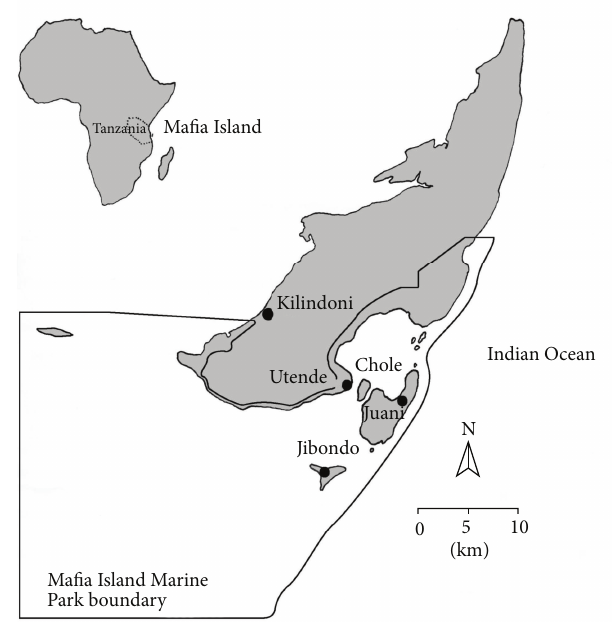
Figure 1: Map of Mafia Island, Tanzania, showing study